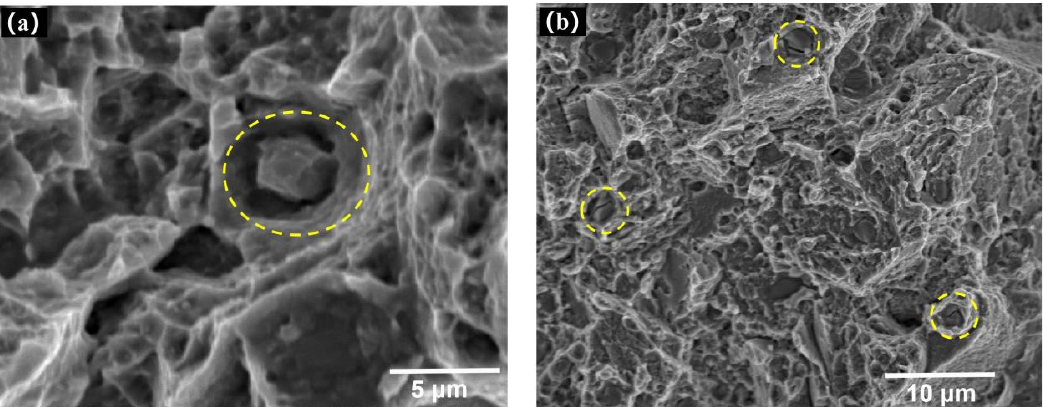
Figure 14. ( a ) Complete second-phase particle, ( b ) broken second-phase